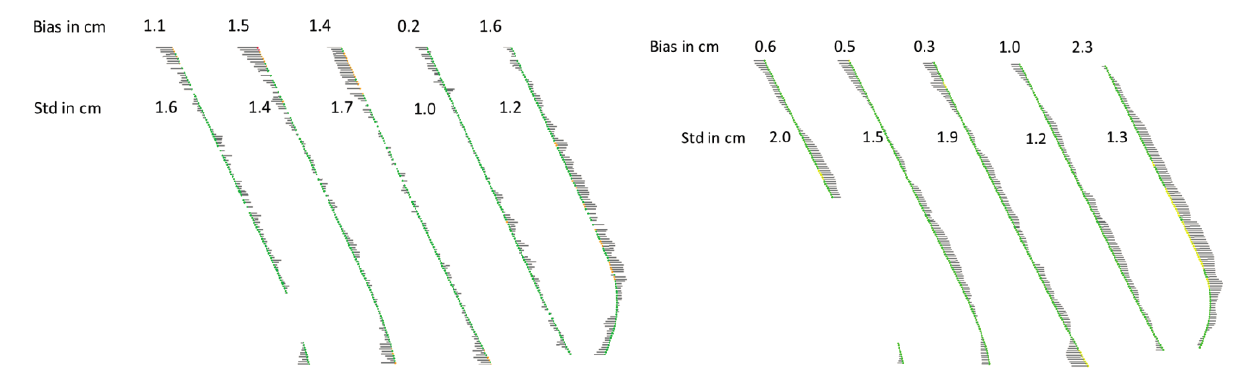
Figure 11. Residuals between generated centerlines and reference data for our data-driven approach ( left ) and the model-driven approach ( right ) in Blerick. Grey lines represent the direction and magnitude of the residuals (magnified by a factor